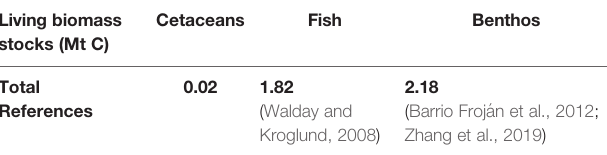
TABLE 8 | Summary of survey area carbon stocks.